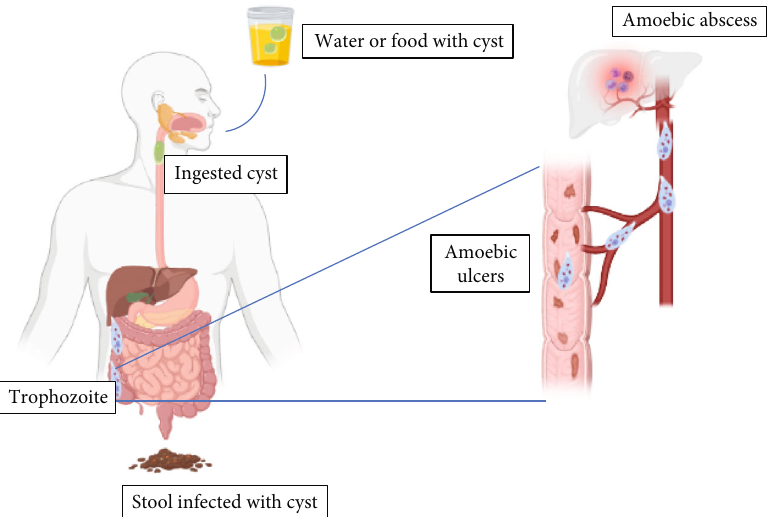
Figure 1: A diagram illustrating a summary of the life cycle E. histolytica and the spread of trophozoites to the liver through the portal